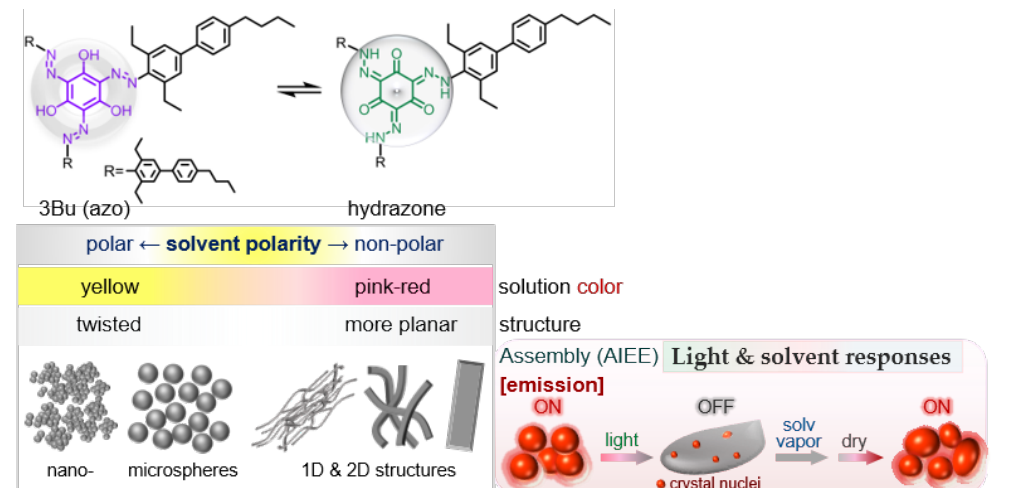
Scheme 1. Upper: Chemical structure. Lower left: The plausible molecular structure preferentially taken under different solvent conditions, the resulting solution color, and the morphology of self- assembled structures. Lower right: Light and solvent responses: Subsequent exposure of a light- irradiated sphere sample to solvent vapor resulted in reversible fluorescence off  on switching accompanied by recovery of the round